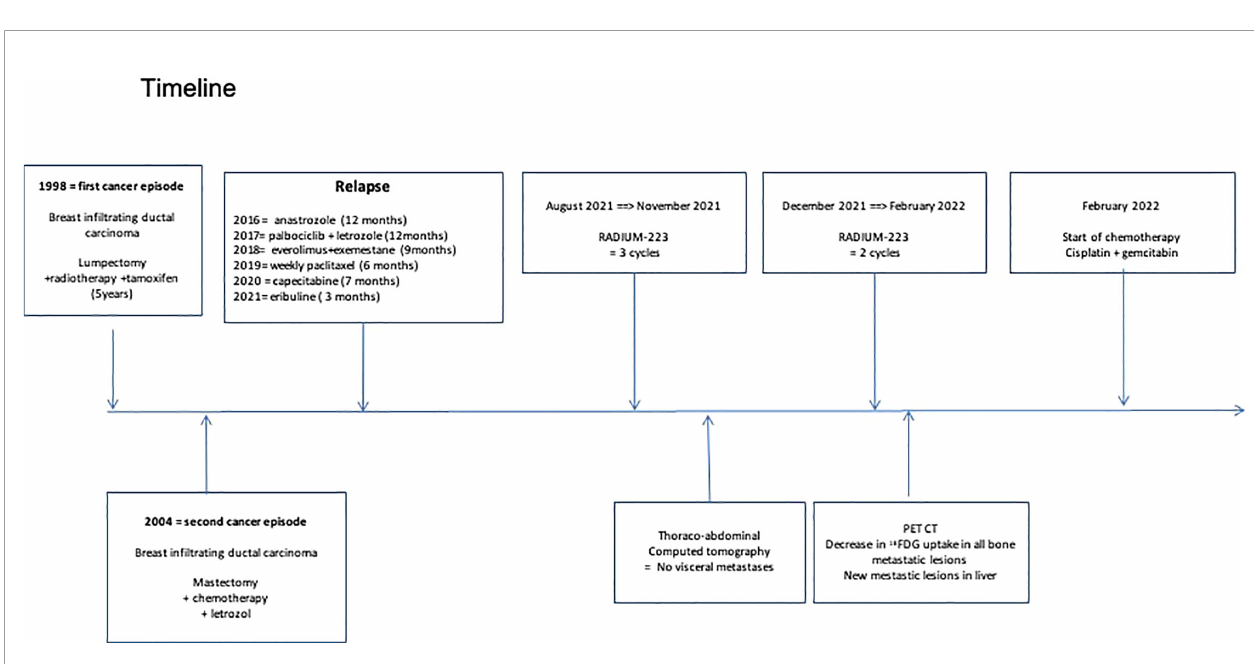
FIGURE 3 | Lumbar spine CT-scan before and after Radium-223 treatment. The CT-scan performed after Radium-223 shows bone formation in lumbar vertebras.